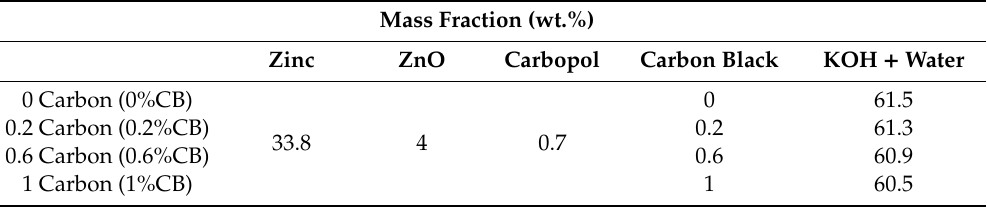
Table 1. Composition of the zinc